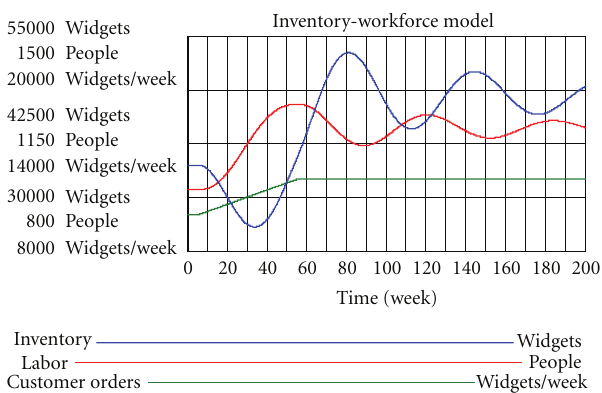
Figure 5: Behavior of state variables for the current policy.